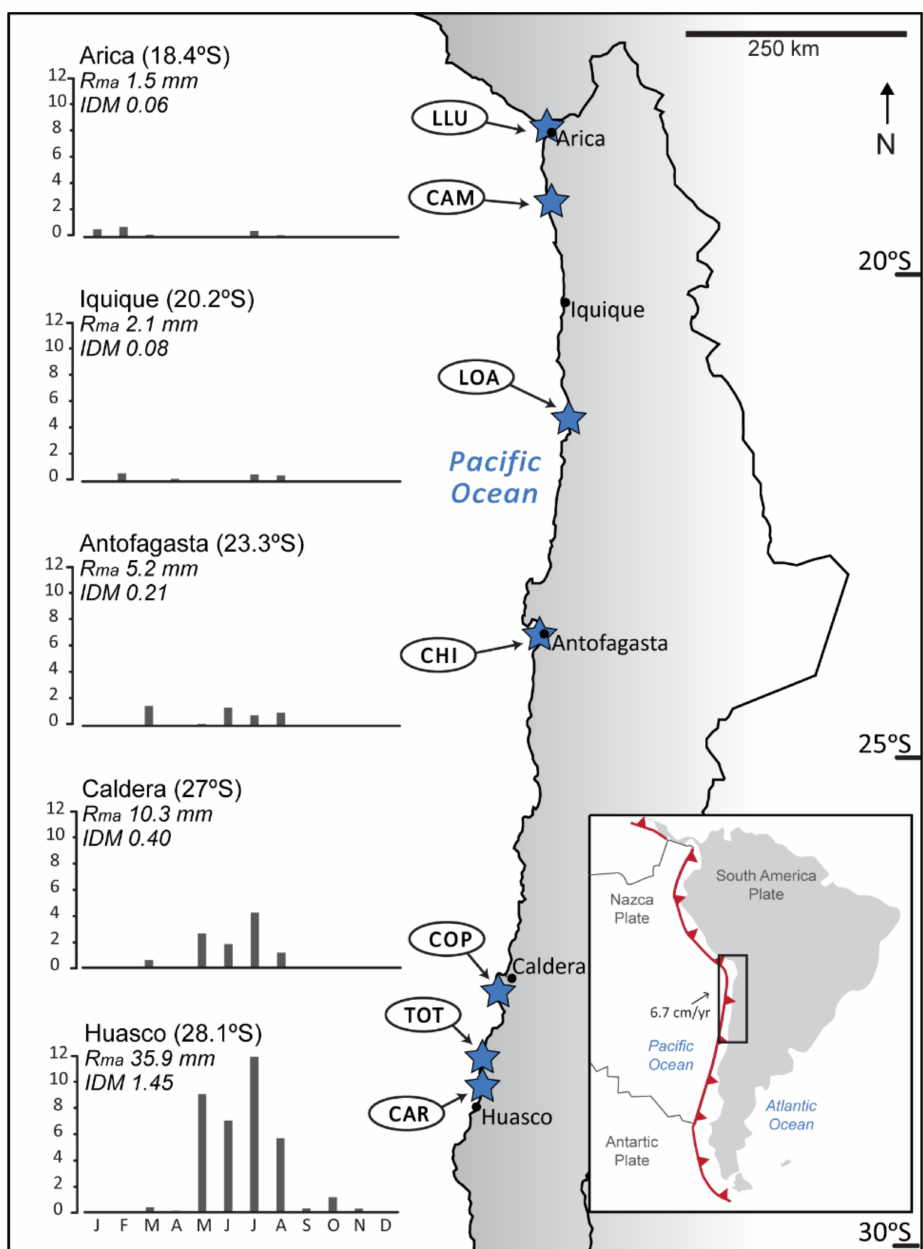
Figure 3. Location of the studied coastal wetlands in northern Chile: LLU, Lluta; CAM, Camarones; LOA, Loa; CHI, La Chimba; COP, Copiap ó ; TOT, Totoral; CAR, Carrizal Bajo. The graphs show monthly rainfall (2010–2020) for the main coastal cities in mm (DGA: www.dga.cl, accessed on 28 June 2021); Rma: annual rainfall (DGA: www.dga.cl, accessed on 28 June 2021); IDM: De Martonne aridity index